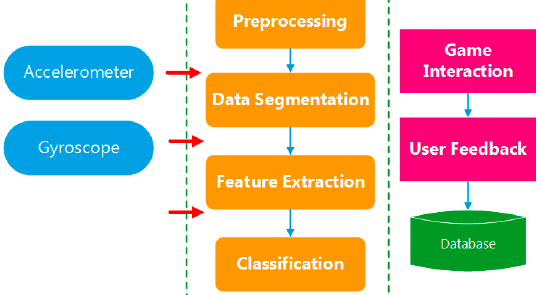
Figure 4. Overview of foot motion identification process.